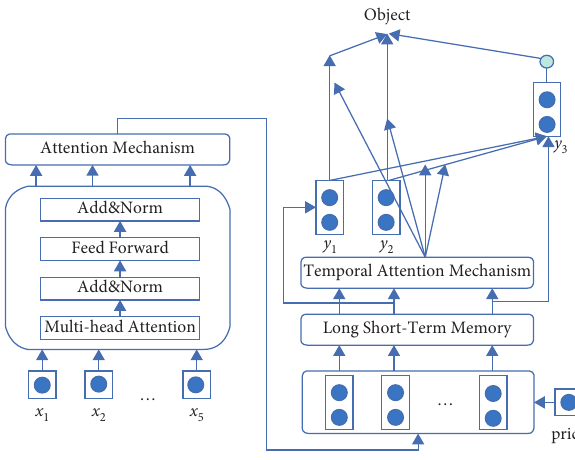
Figure 1: The architecture of